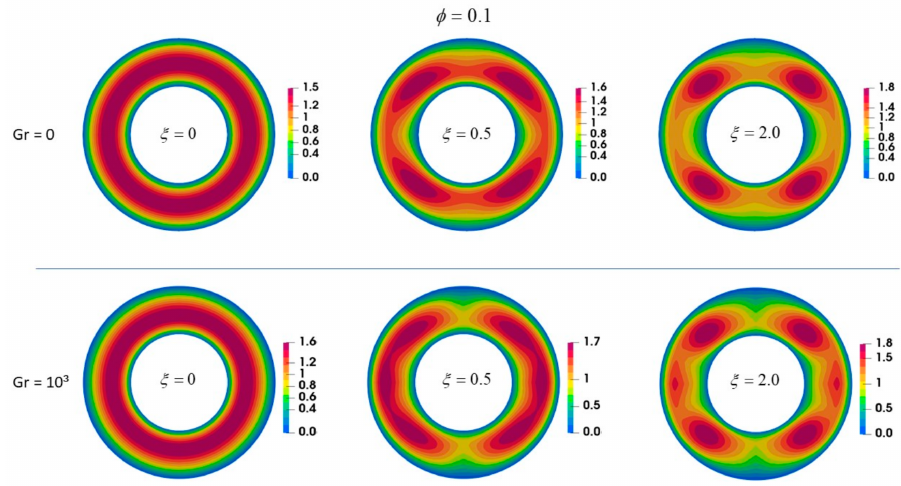
Figure 2. Contour plots of the axial velocity (cid:101) v ζ for various values of ξ and Gr for φ = 0.1. The contour plots of the streamlines of the transverse components of the velocity for various values of ξ and Gr and for concentration φ = 0.1 are shown in Figure 3 Due to the effect of the field strength, the transverse components of the velocity form two pairs of vortices (one clockwise and one anticlockwise) on each region of the duct near angles θ = 45 ◦ , 135 ◦ , 225 ◦ , 315 ◦ . As the field strength increases, the value of the stream function ψ also increases. Grashof number increase has a minor effect on the streamline values. Only for ξ = 0.1 is the absolute value of the stream function ψ slightly increased. For ξ ≥ 0.5, the Grashof number has zero effect on the streamlines. This is due to the vertical alignment of the duct, because buoyancy forces are formulated in the axial